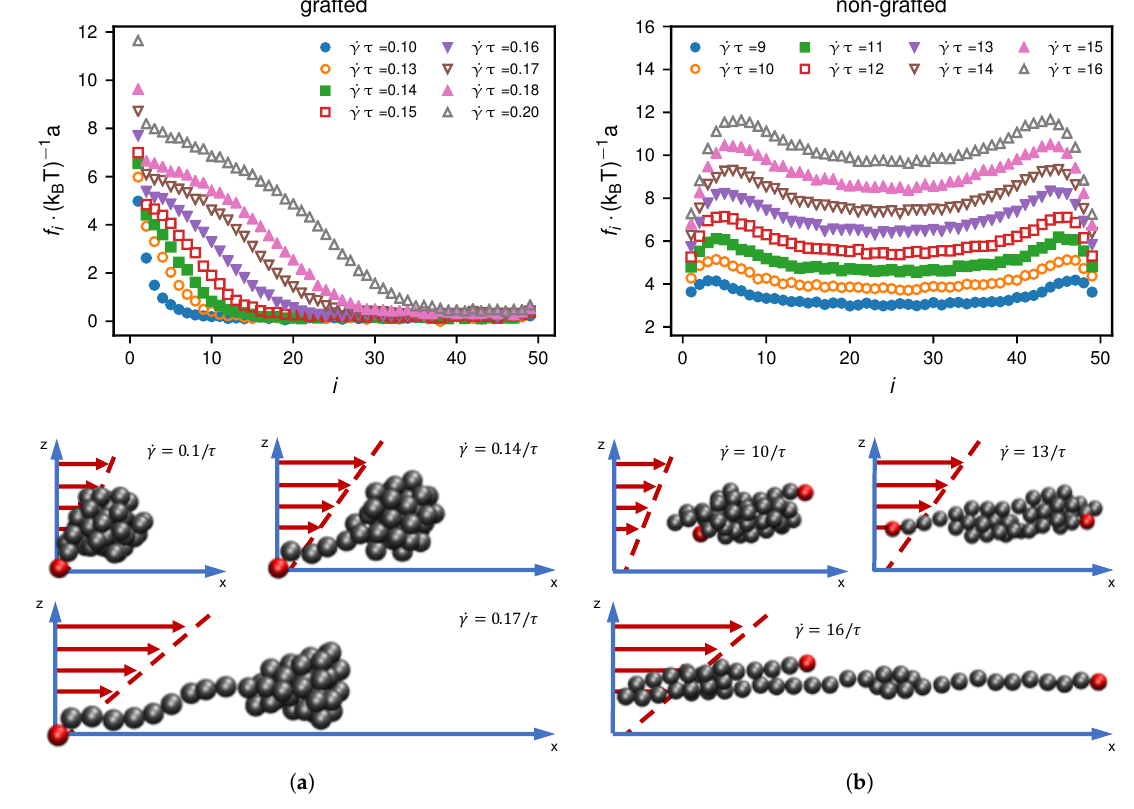
Figure 7. Comparison of tensile force profiles of a bead-spring chain with N = 50 for different shear rates in the vicinity of the critical shear rate ˙ γ ∗ = 0.168 τ − 1 for the ( a ) grafted and ˙ γ ∗ = 13 τ − 1 for the ( b ) non-grafted case. These critical shear rates are based on the maximum of the numerical derivatives of R 2 . We also present simulation snapshots that illustrate the different unfolding mechanisms in the S grafted and non-grafted